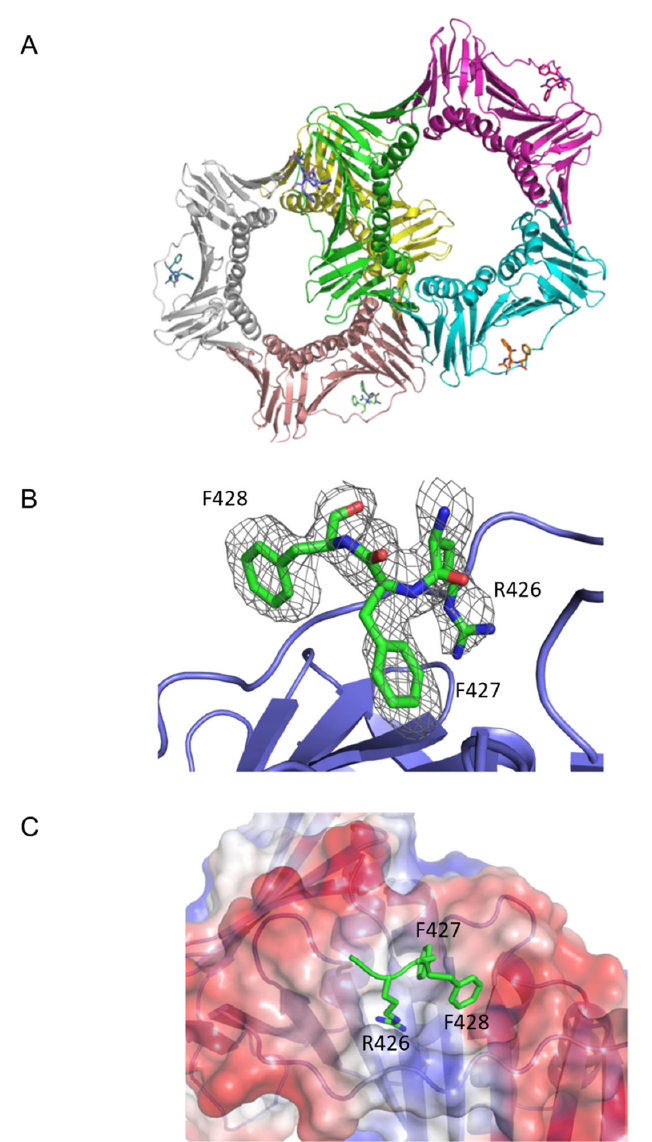
Figure 2. CAF-1 p150 PIP binding to PCNA. ( A ) The two PCNA homo-trimers are present in the asymmetric unit. Each PCNA monomer is bound to a PIP. Three CAF-1 p150 PIP residues (RFF) are depicted in stick representation. PIP binding occurs on a hydrophobic surface located between the interdomain connecting loop (IDCL) and the underlying β -sheet of PCNA. ( B ) p150 PIP (green) is shown in stick representation, with F0-dFc omit electron density map contoured at 1.0 σ covering the p150 residues. Only the RFF residues are shown in the model. PCNA is shown in blue. ( C ) The p150 PIP interacts with a hydrophobic surface of PCNA. Three residues of the CAF-1 p150 PIP, Arg 426, Phe 427, and Phe 428 are shown in stick representation (green). PCNA is represented with surface electrostatics calculated to a solvent radius of 1.5 Å. Red corresponds to negatively charged residues, blue to positively charged residues, and white to an uncharged surface.